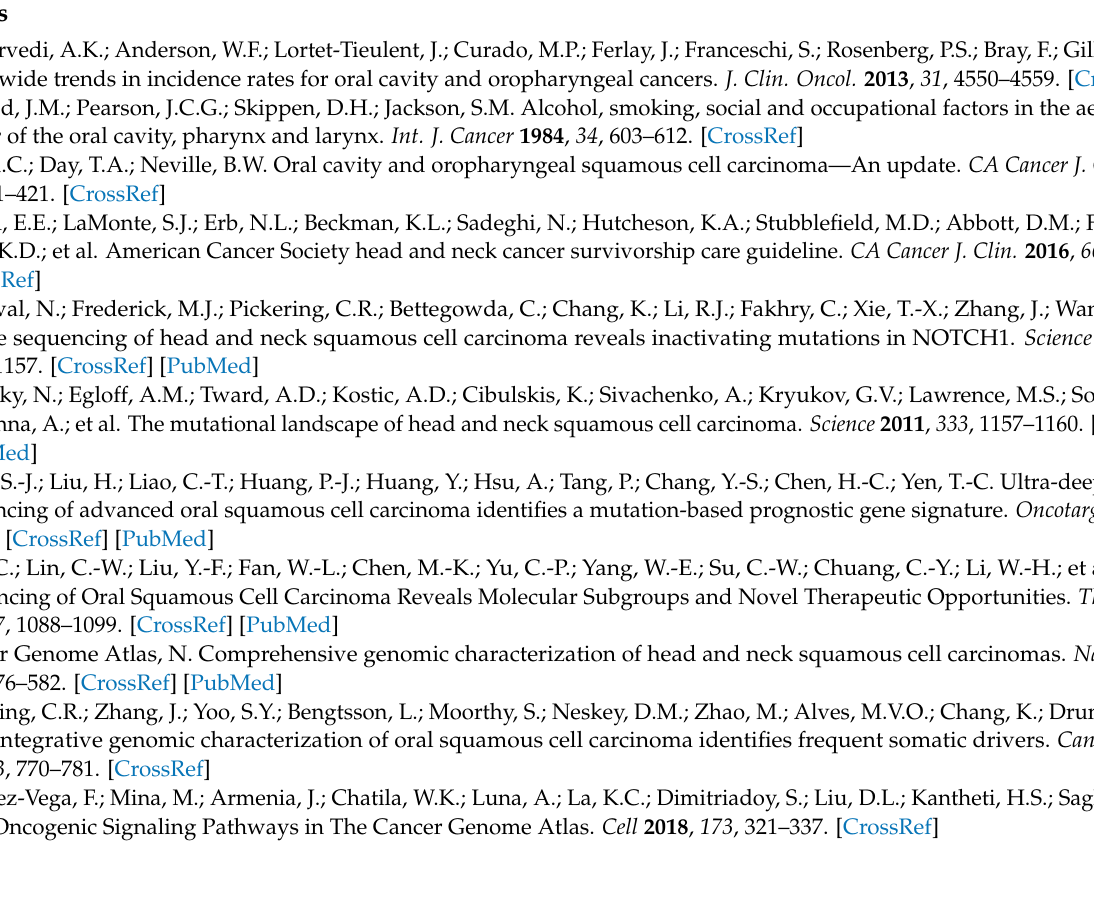
Table S8: Significantly mutated genes in 165 oral cavity squamous cell carcinoma (OCSCC) of whole exome sequencing by using MutSigCV2.0, Table S9: Mutually exclusive and co-occurring oncogene Table S10: Univariant and multivarinat analysis for the effect on the patient